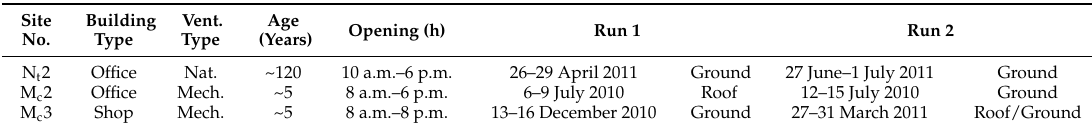
Table 1. Monitoring sites summary and